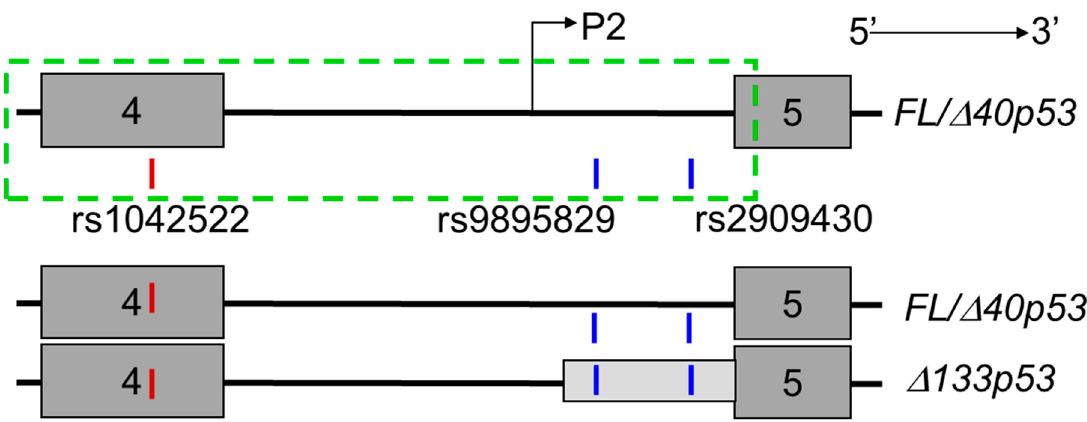
Figure 1. Schematic illustrating the location of rs1042522, rs9895829 and rs2909430 within the TP53 gene spanning exons 4–5. The dark grey boxes indicate the exons, the light grey box indicates the untranslated region (UTR) of the ∆ 133TP53 transcripts. The black line connecting the exons (dark grey boxes) indicates the intronic region (intron 4). P2–P2 promoter, and the dotted green box indicates the genomic region representing the P2 promoter. The exonic SNP is shown as a red vertical line (rs1042522) and intronic single nucleotide polymorphisms (SNPs) are shown as blue vertical lines (rs9895829 and rs2909430).